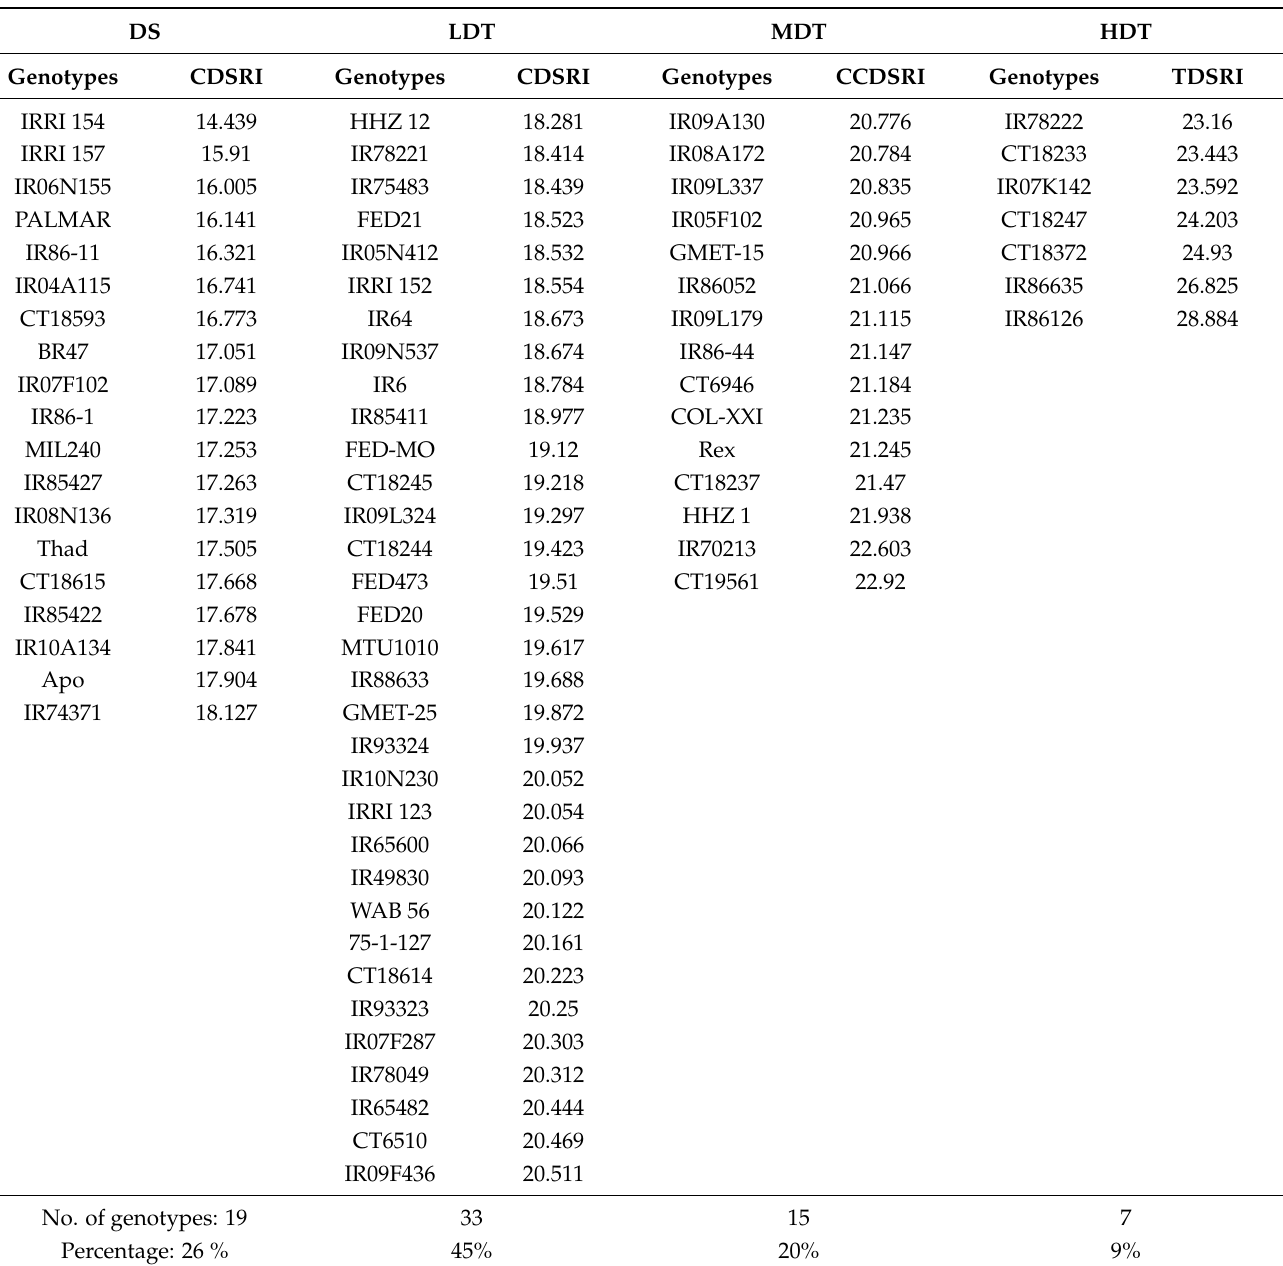
Table 2. Classification of 74 tropical rice genotypes into different groups, including drought- susceptible (DS), low drought-tolerant (LDT), moderately drought-tolerant (MDT), and highly drought-tolerant (HDT) genotypes, using shoot and root combined drought response indices of morpho-physiological parameters at the seedling stage.